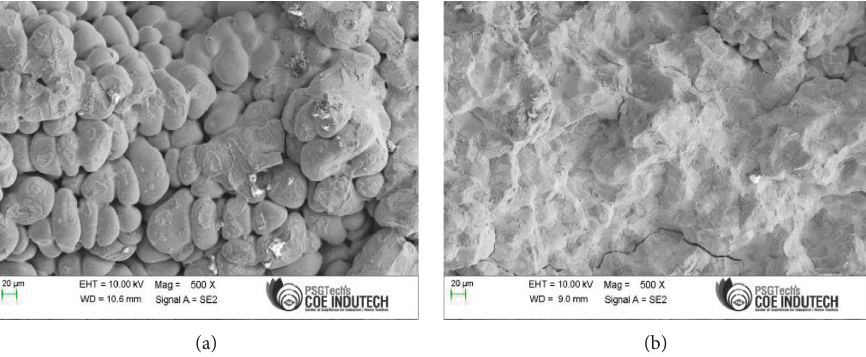
Figure 13: SEM morphology of fractured AA7075/1wt%TaC/8wt%Si